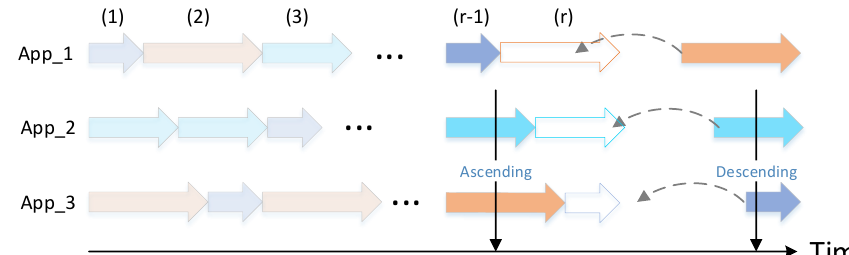
Figure 4. The mathematical modeling of the Simplest Allocation